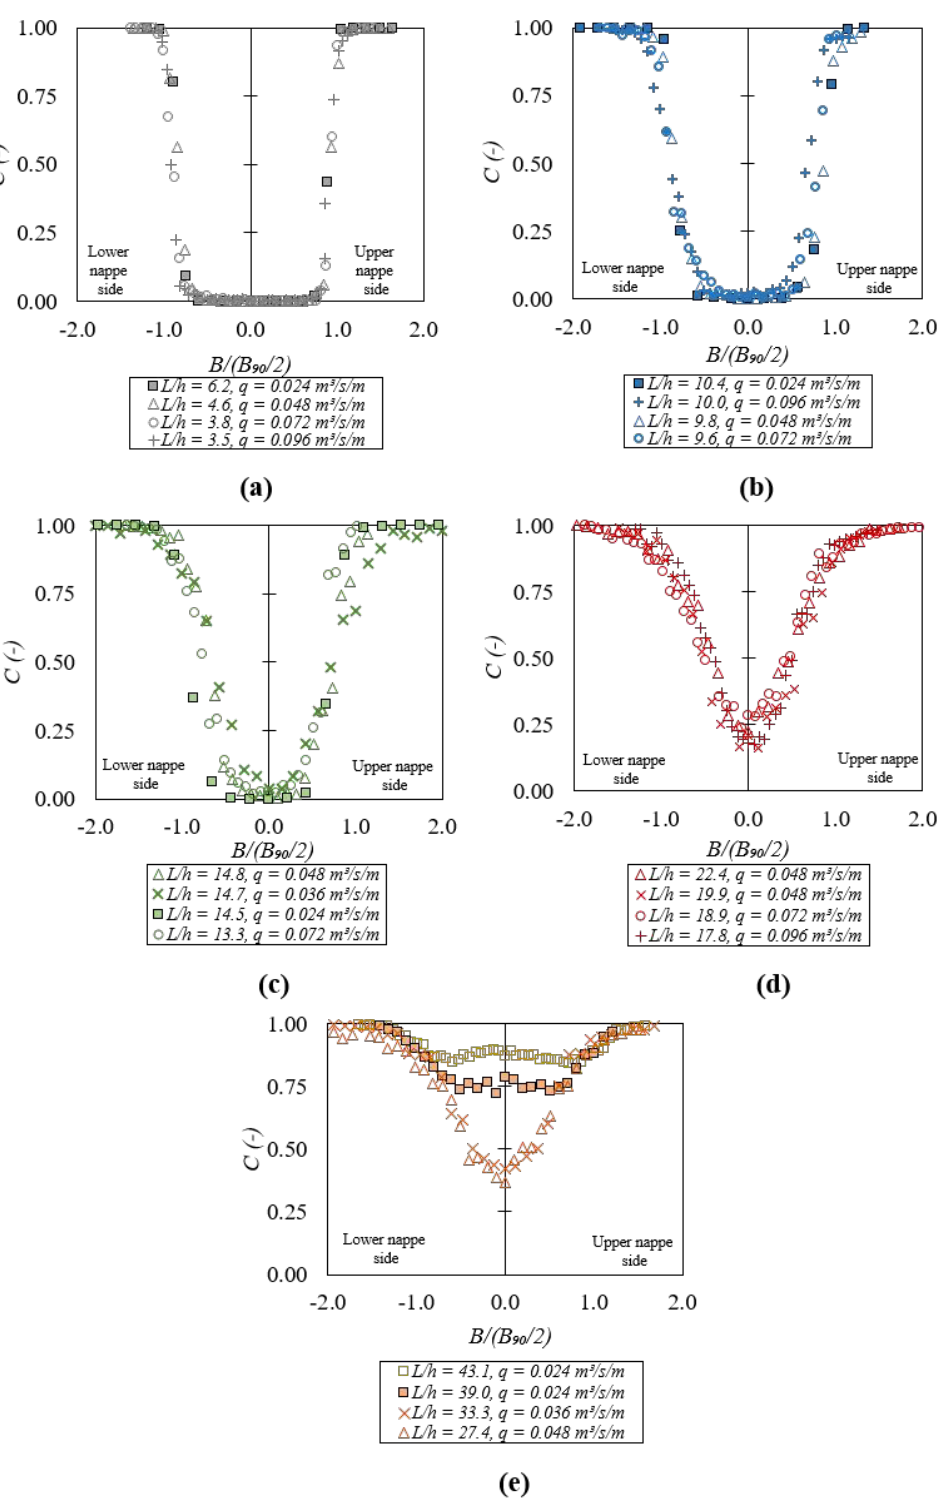
Figure 4. Void fraction distributions as a function of the dimensionless jet thickness B /( B 90 /2): ( a ) L/h ratio between 3.5 and 6.2; ( b ) L/h ratio between 9.6 and 10.4; ( c ) L/h ratio between 13.3 and 14.8; ( d ) L/h ratio between 17.8 and 22.4; ( e ) L/h ratio between 27.4 and 43.1.